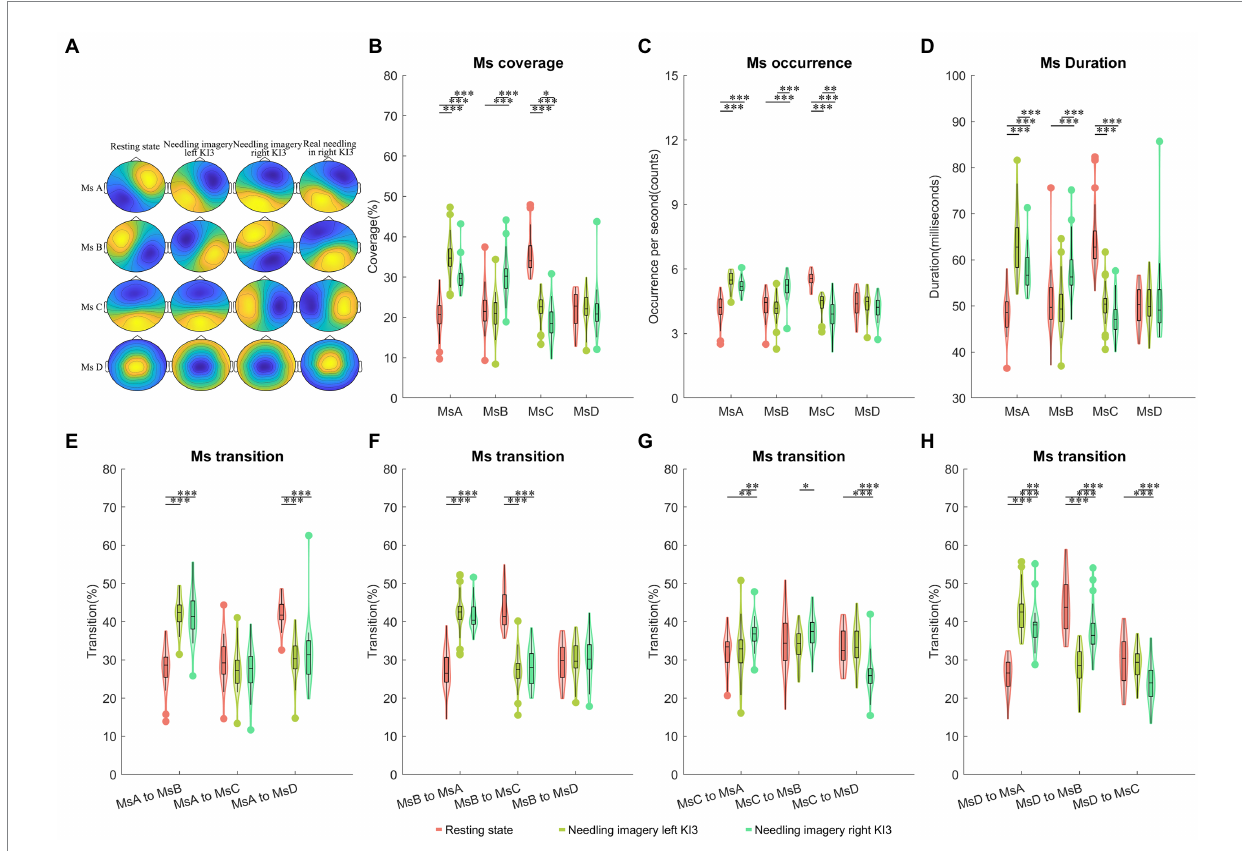
FIGURE 2 Temporal dynamics of EEG microstates within AI group. (A) The four microstates were recognized by k-means cluster analysis across subjects in the four conditions (resting state, needling imagery in left KI3, needling imagery right KI3 within AI group, and real needling in right KI3 of RA group). (B) The coverage of the four microstates in each condition within AI group. (C) The occurrence per second of the four microstates in each condition within AI group. (D) The duration of the four microstates in each condition within AI group. (E–H) Markov chain transition probabilities of the four microstates in each condition within AI group. Post-hoc Tukey–Kramer tests were carried out when the ANOVA revealed significant group differences at p < 0.05. post hoc test with FDR correction * p < 0.05, ** p < 0.01, *** p < 0.001; Ms, microstate; AI, acupuncture